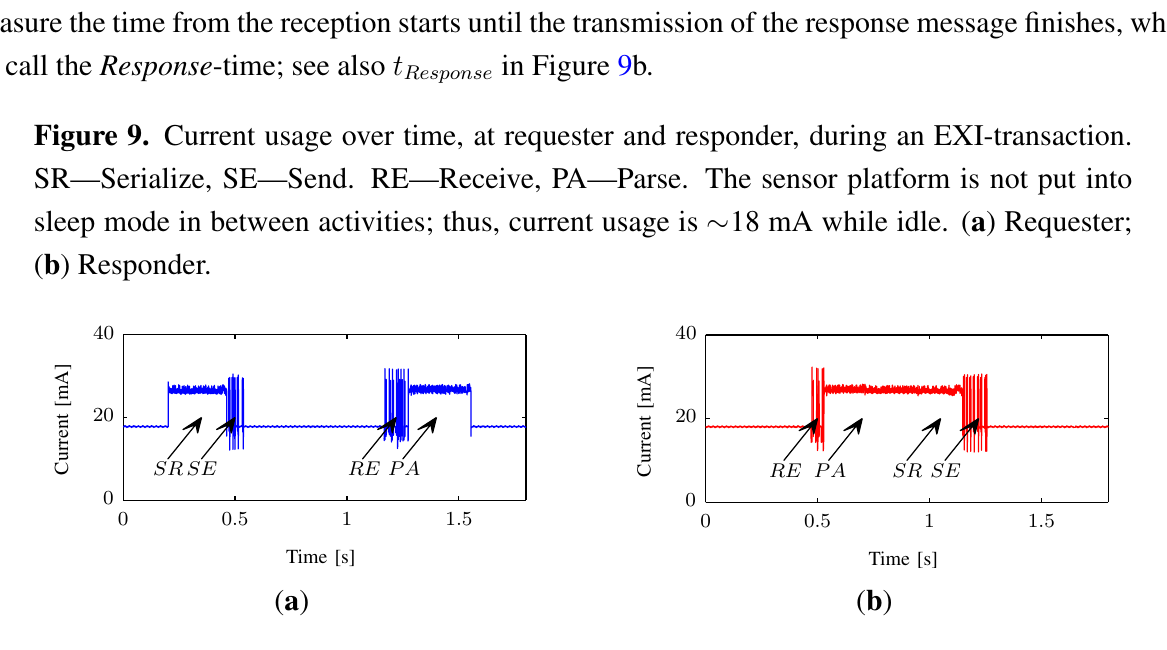
Figure 9. Current usage over time, at requester and responder, during an EXI-transaction.